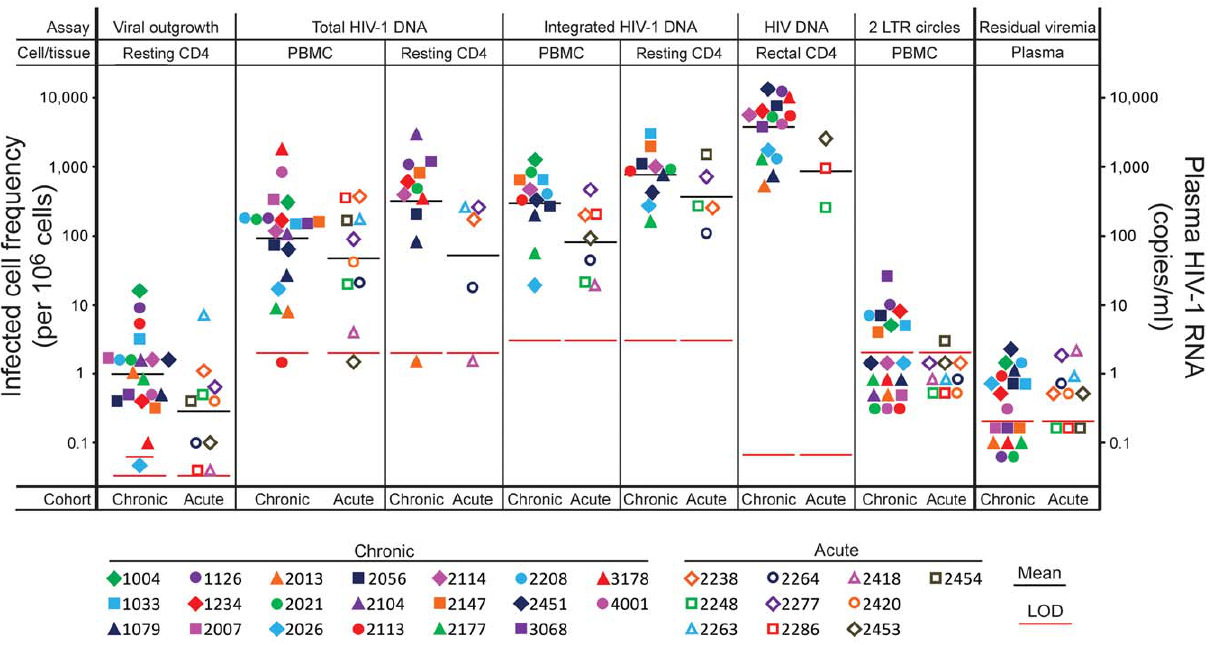
Figure 1. HIV-1 persistence assessed by six different assays performed on the indicated cell or tissue obtained from patients starting HAART during acute/early infection (open symbols) or chronic infection (closed symbols). Geometric mean values are indicated by a horizontal black line. Long red lines indicate the limit of detection (LOD) for the relevant assay with a standard input sample size. Short red lines indicate patient-specific limits of detection in cases where the blood or tissue sample was smaller than normal. Negative assays are indicated by samples plotted below the red LOD lines.